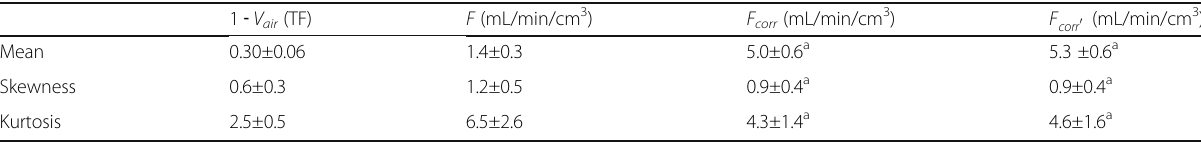
Table 2 Summary of TF and